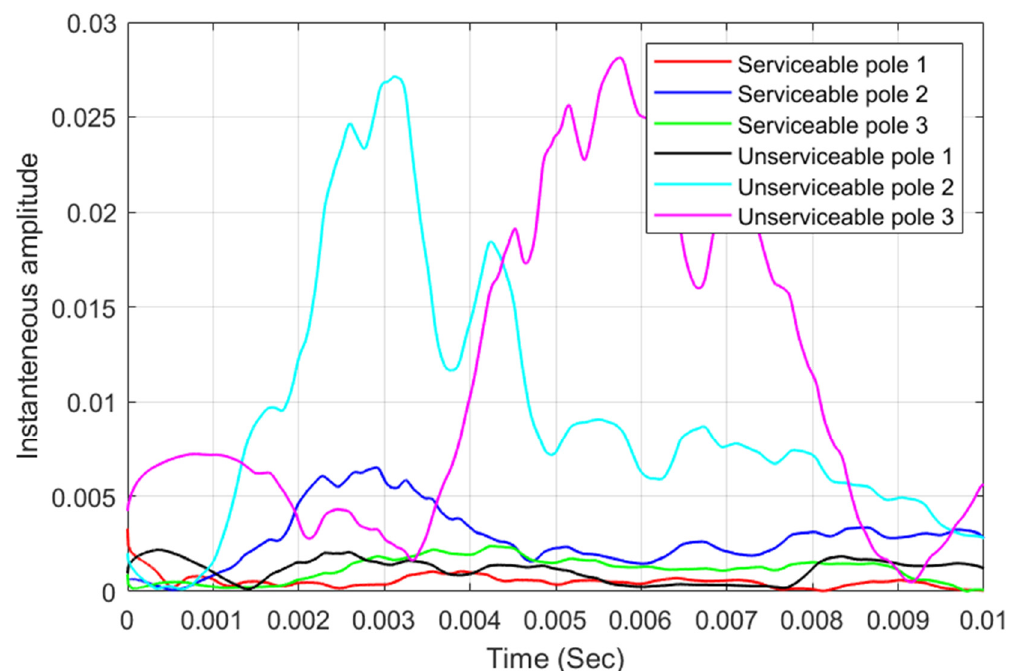
Figure 22. Instantaneous amplitude of IMF1 for A0R1 considering 3 serviceable poles and 3 unserviceable poles.